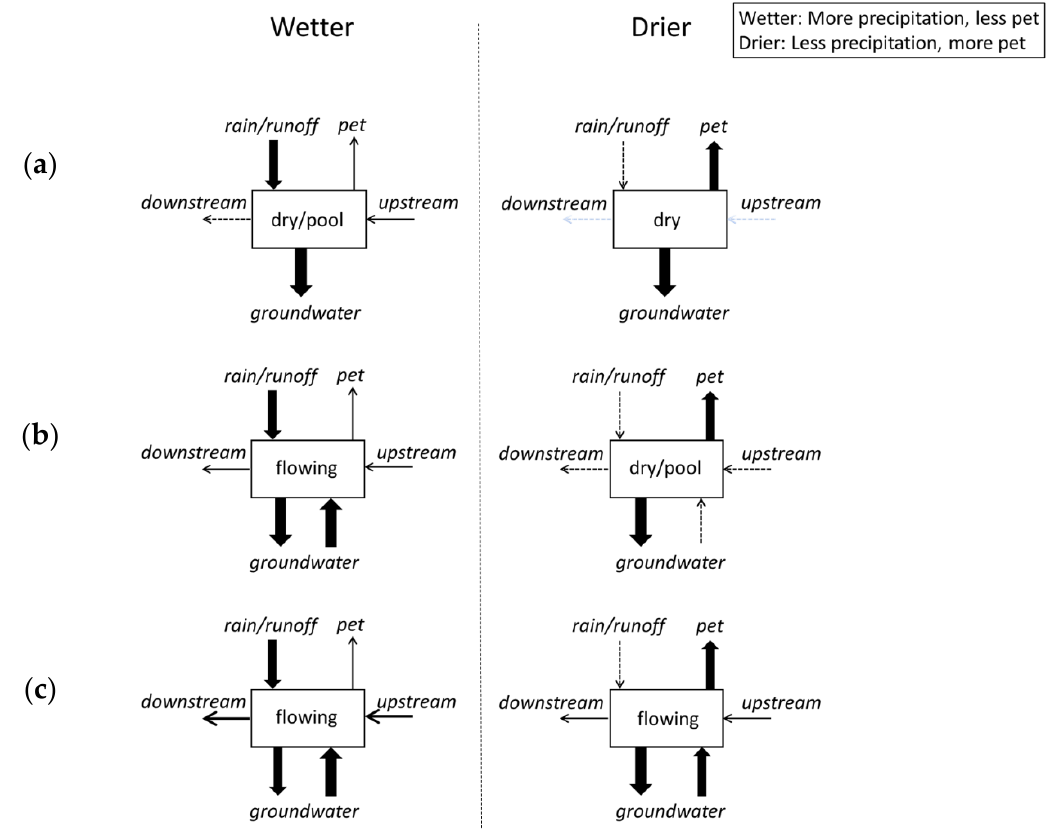
Figure 1. Conceptual figure illustrating differences among ephemeral ( a ), intermittent ( b ), and perennial ( c ) reaches during wetter and drier periods. Typical baseflow hydrologic conditions of the stream reach (box) are shown. The arrow thickness illustrates the relative magnitude of catchment inputs (rain/runoff, groundwater) and outputs (potential evapotranspiration (pet), groundwater) that influence hydrologic connection within a stream reach.